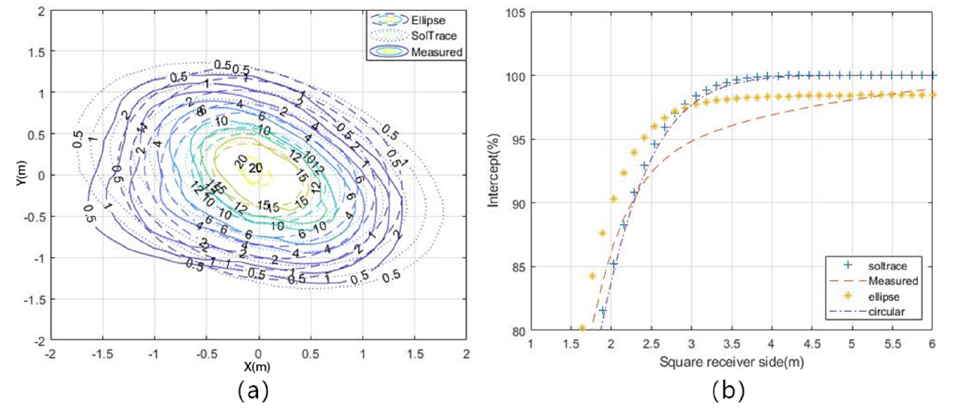
Figure 13. ( a ) Contours of the measured and computed flux distribution (kW/m 2 ): Heliostat #7, ( b ) measured and computed intercepts vs. the side length of a square receiver: Heliostat #7 .